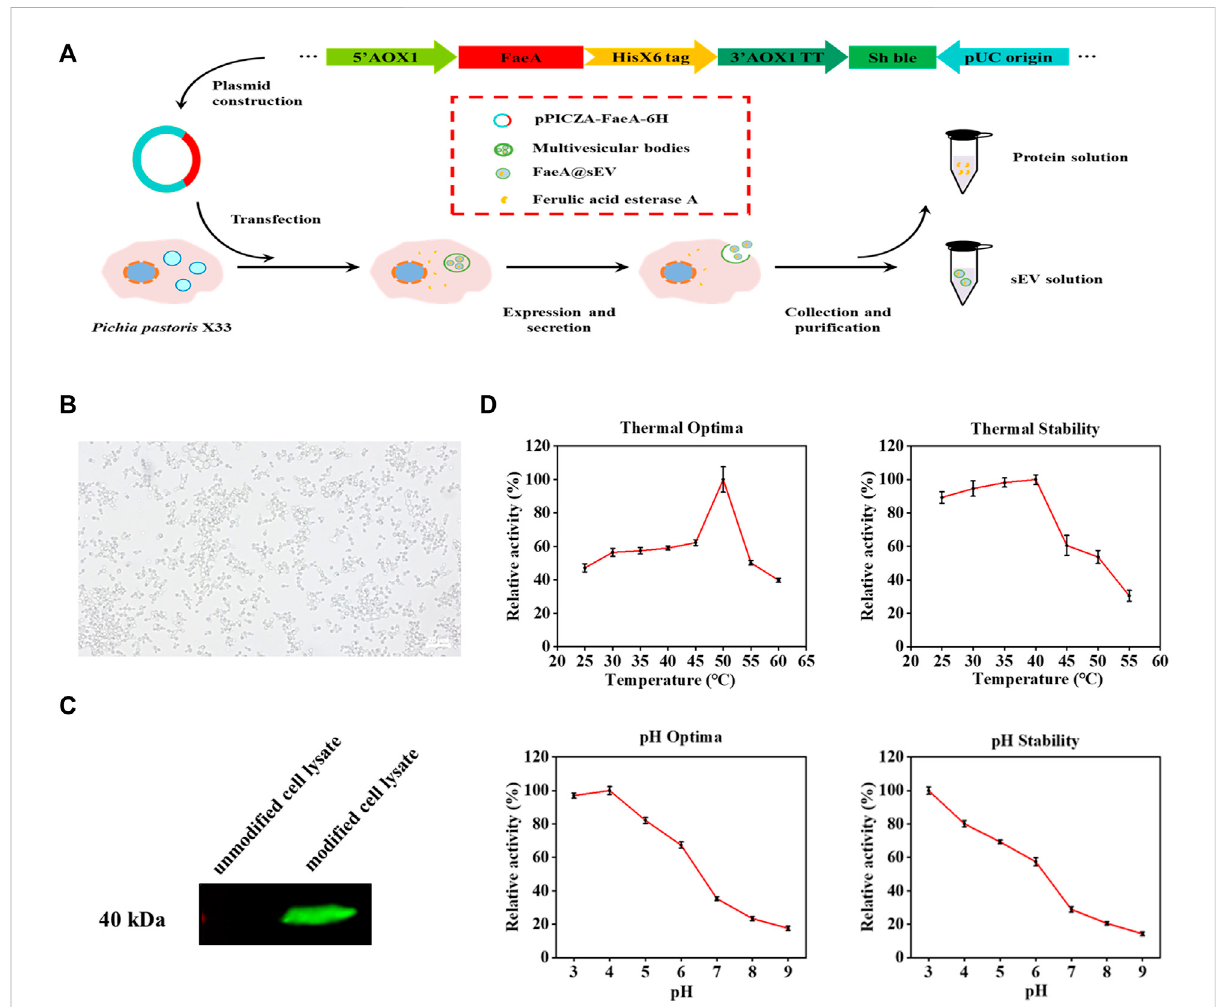
FIGURE 2 Clonal expression and enzymatic properties of FaeA gene. (A) The construction process of recombinant yeast expressing FaeA gene. (B) Inverted microscope imaging of how recombinant yeast grows. (C) Identi fi cation of FaeA in modi fi ed cell lysates by western blotting. (D) The enzymatic properties of FaeA. ( n = 3, mean ±